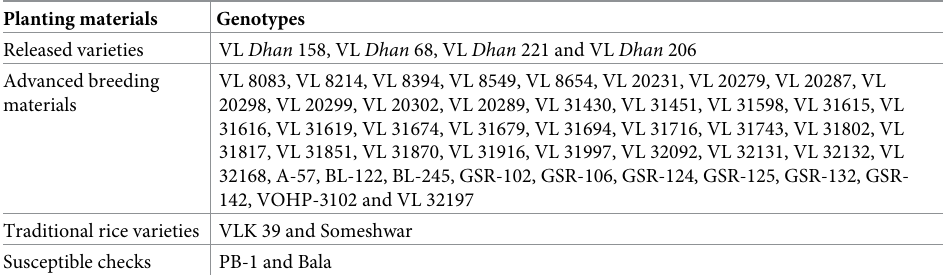
Table 1. List of 52 rice accession used in this study.